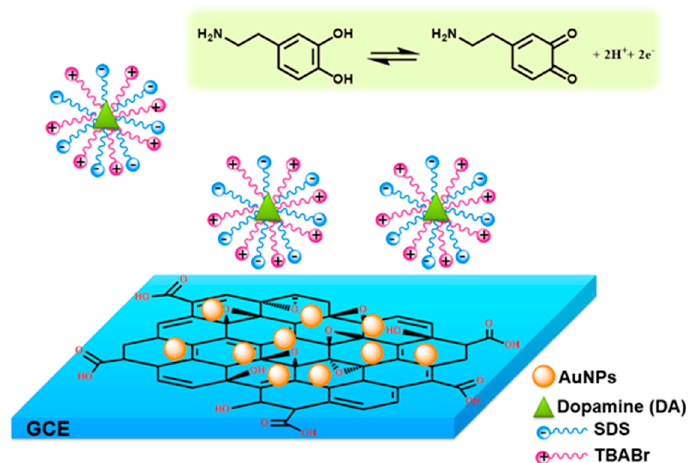
Figure 5. Schematic model illustrating interaction of DA and supramolecular electrochemical sensor as TBABr / SDS ··· AuNPs / GO /